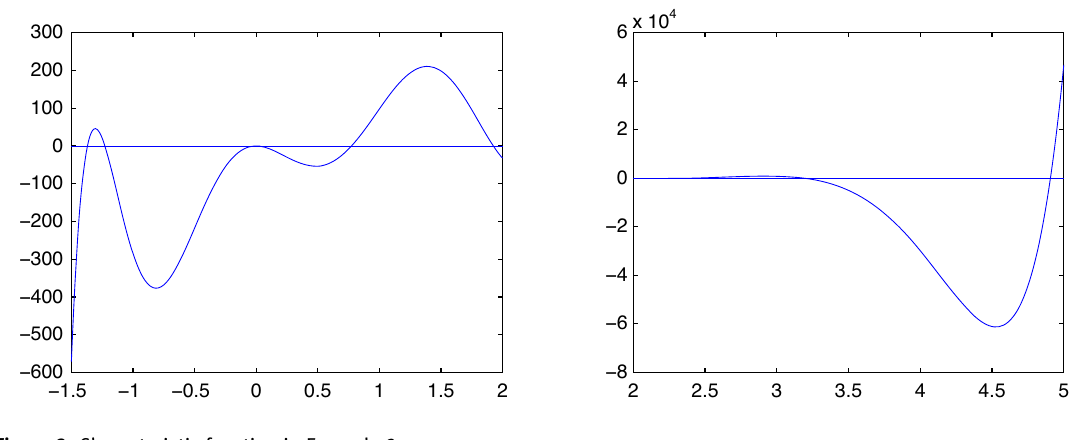
Figure 2: Characteristic function in Example